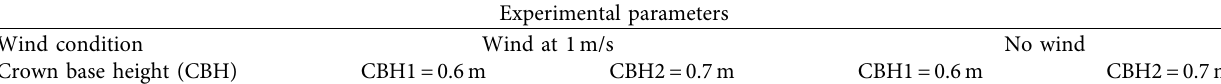
Table 1: Summary of experimental parameters for the four experimental treatments considered.